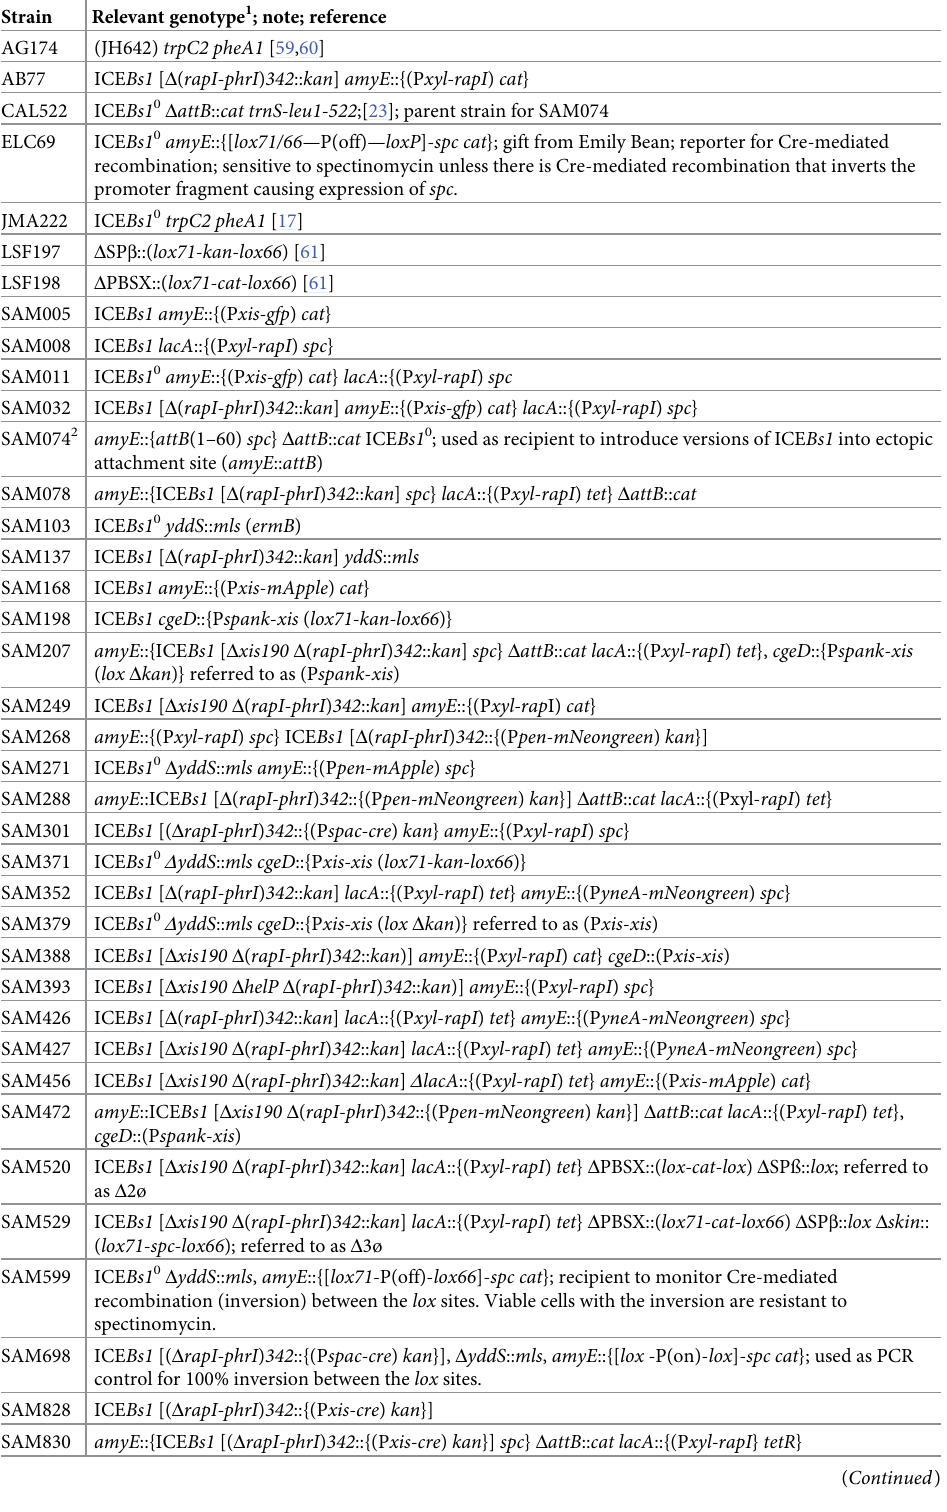
Table 3. B . subtilis strains